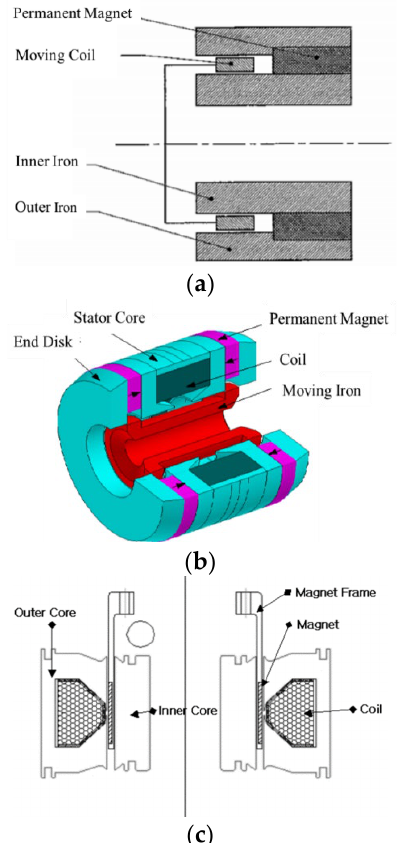
Figure 1. Examples of three types of linear motors: ( a ) moving coil [14] ( b ) moving iron [15] ( c ) moving magnet [16].